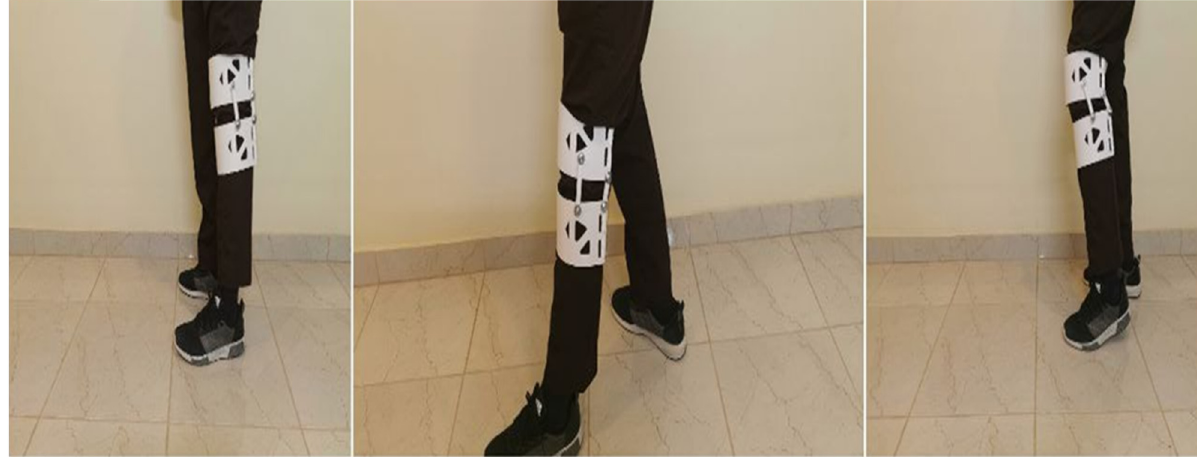
Figure 10: Testing knee exoskeleton